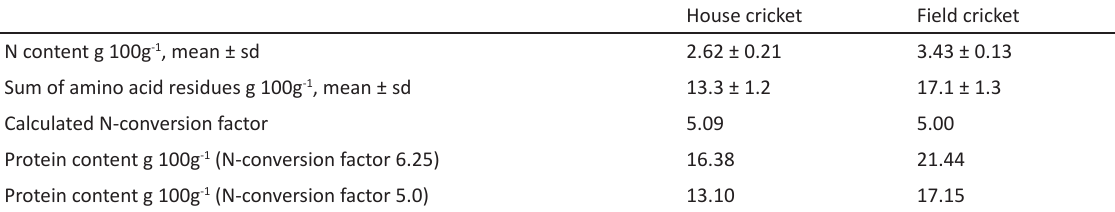
Table 3. Nitrogen contents, sums of amino acid residues, calculated N-conversion factors, and calculated protein contents in two cricket species. (Nitrogen analysis n=8, amino acid analysis n=9-18). For the calculation of the standard deviation of the sum of amino acid residues, an average of the tryptophan result was used, as the tryptophan was measured from different individuals than all other amino acid